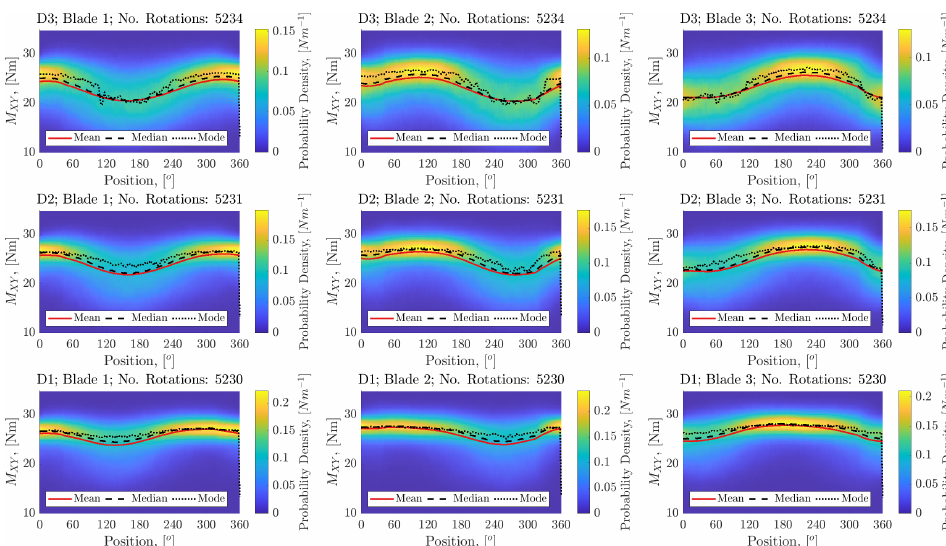
Figure 16. The probability density of M XY , as distributed with rotational position, with mean, median and mode averages overlaid for the JSP cases. Position reference: 0 ◦ is the rotor position when blade 3 at top, dead centre or pointing upward toward the water’s surface.